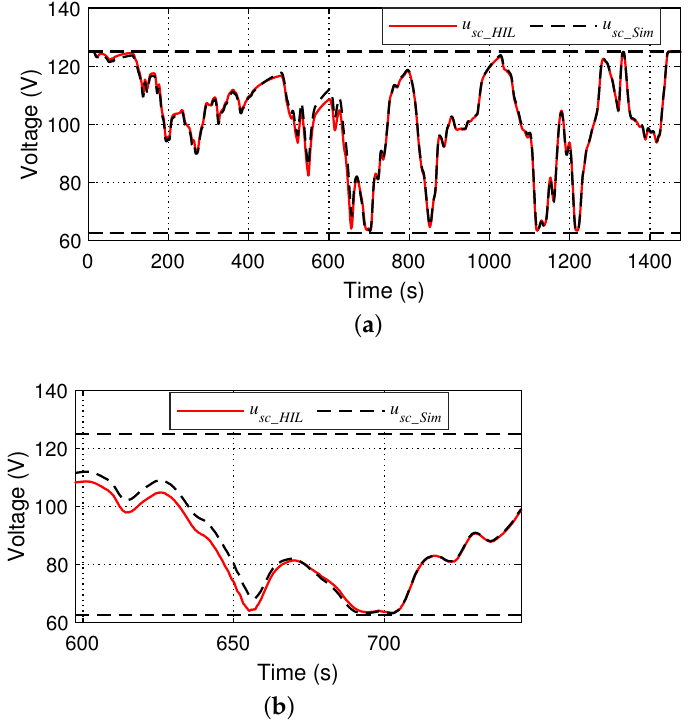
Figure 20. Experimental results of the SC voltage (energy-based strategy): ( a ) Full driving cycle; ( b ) Zoom